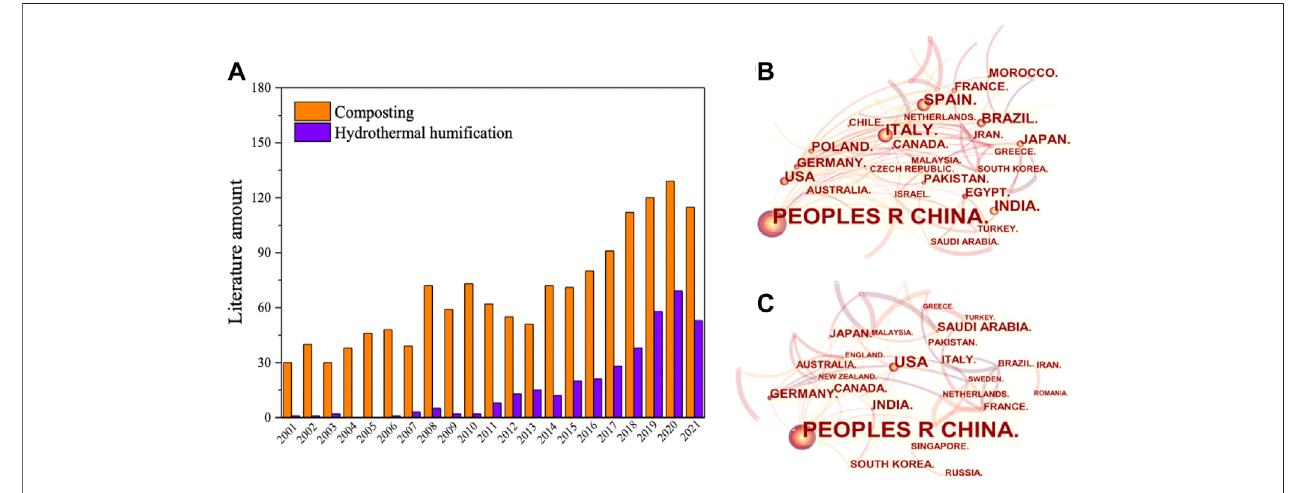
FIGURE1| Recentstudiesoncompostingandhydrothermaltreatmentforbiomasshumi fi cation. (A) Amountofrelativeliteraturesfrom2001to2021; (B) research interest in the fi eld of composting humi fi cation in major countries; (C) research interest in the fi eld of hydrothermal humi fi cation in major